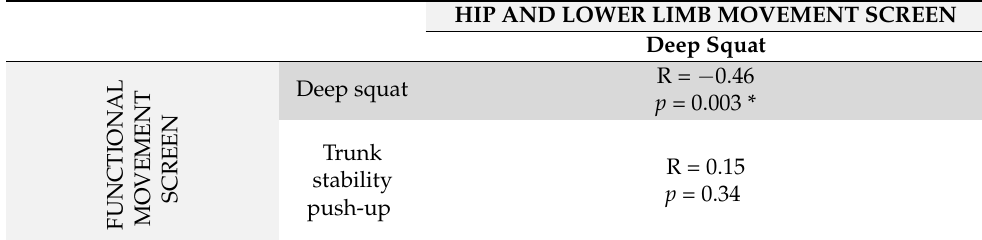
Deep Squat R = − 0.46 p = 0.003 * R = 0.15 p =